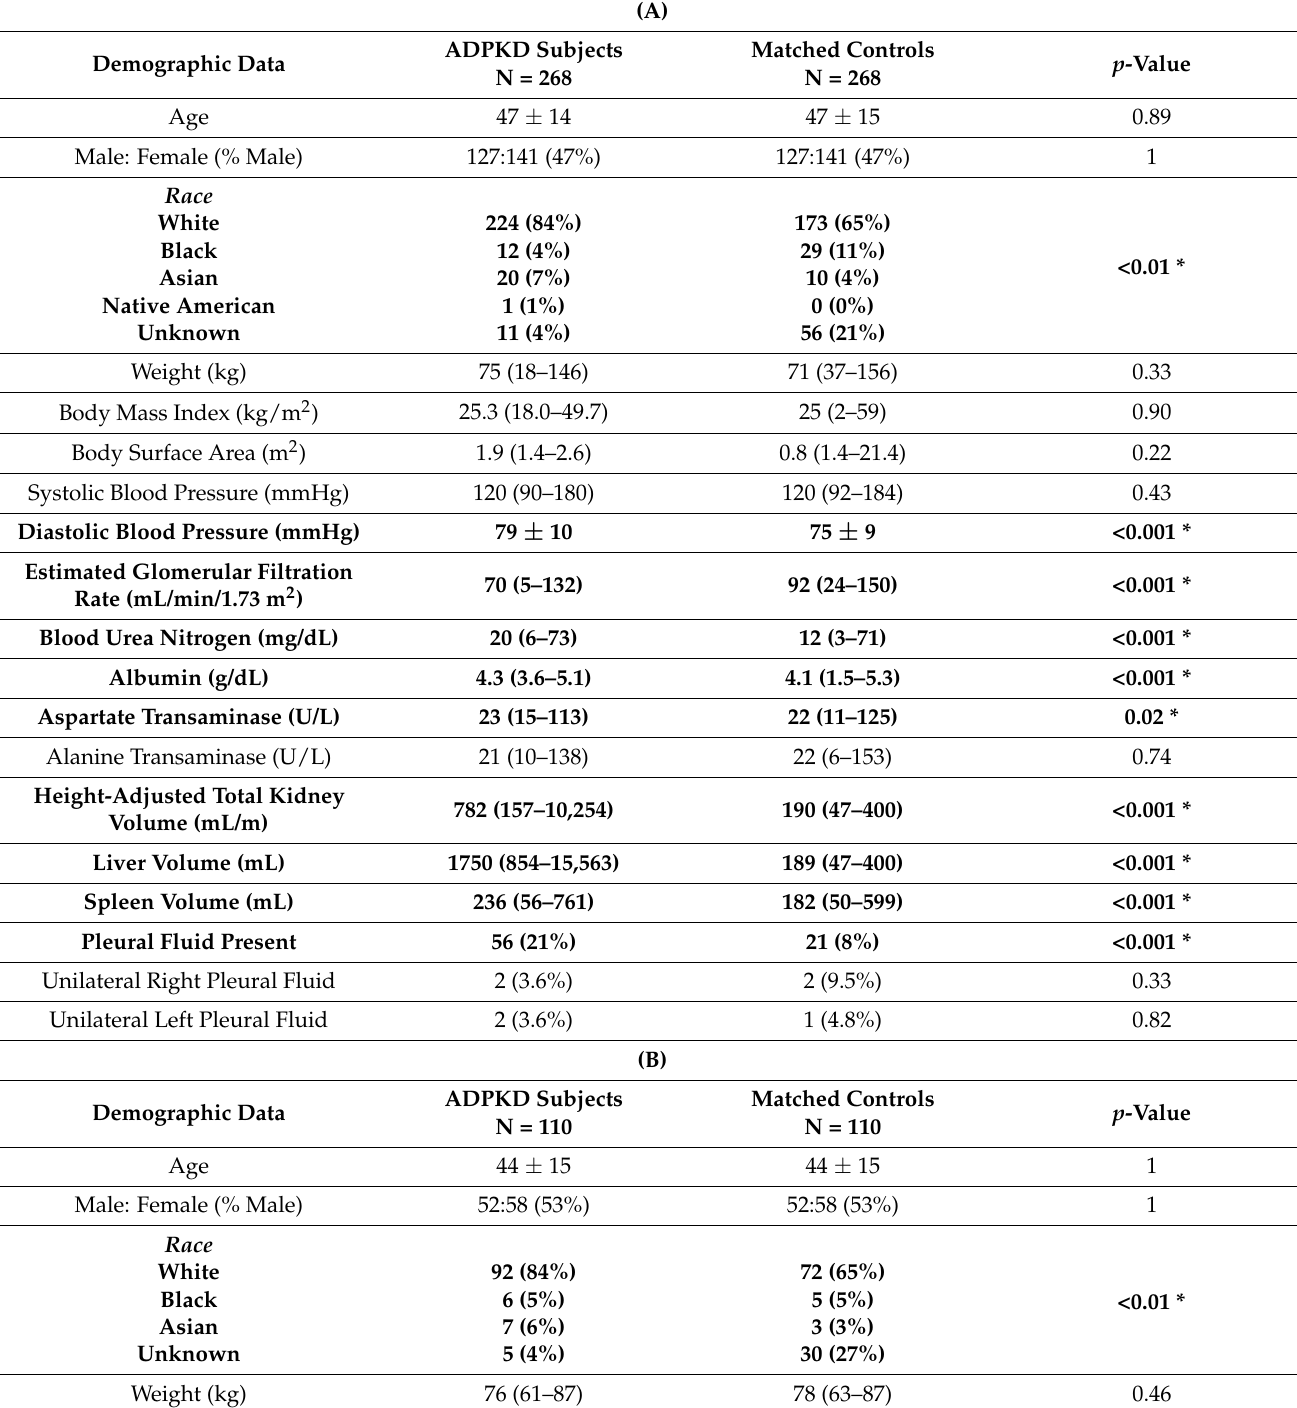
Table 2. ( A ). Demographic and laboratory data in 268 ADPKD subjects and 268 controls matched for age and gender. Continuous variables are given as mean ± standard deviation. Ordinal variables are shown as number followed by the percentage. ( B ). Demographic and laboratory data in a subgroup of 110 ADPKD subjects and 110 matched controls who are also matched for renal function by CKD stage. Note that there is no difference in eGFR between the two subgroups but there continues to be a significantly higher prevalence of pleural effusion in ADPKD